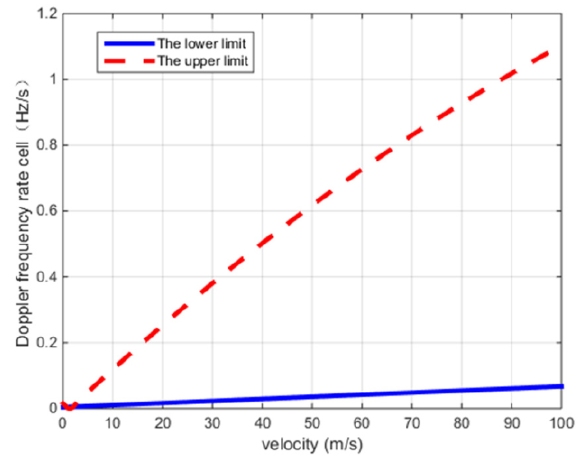
Figure 8. The relationship between the target velocity and the optional cell interval in DFR